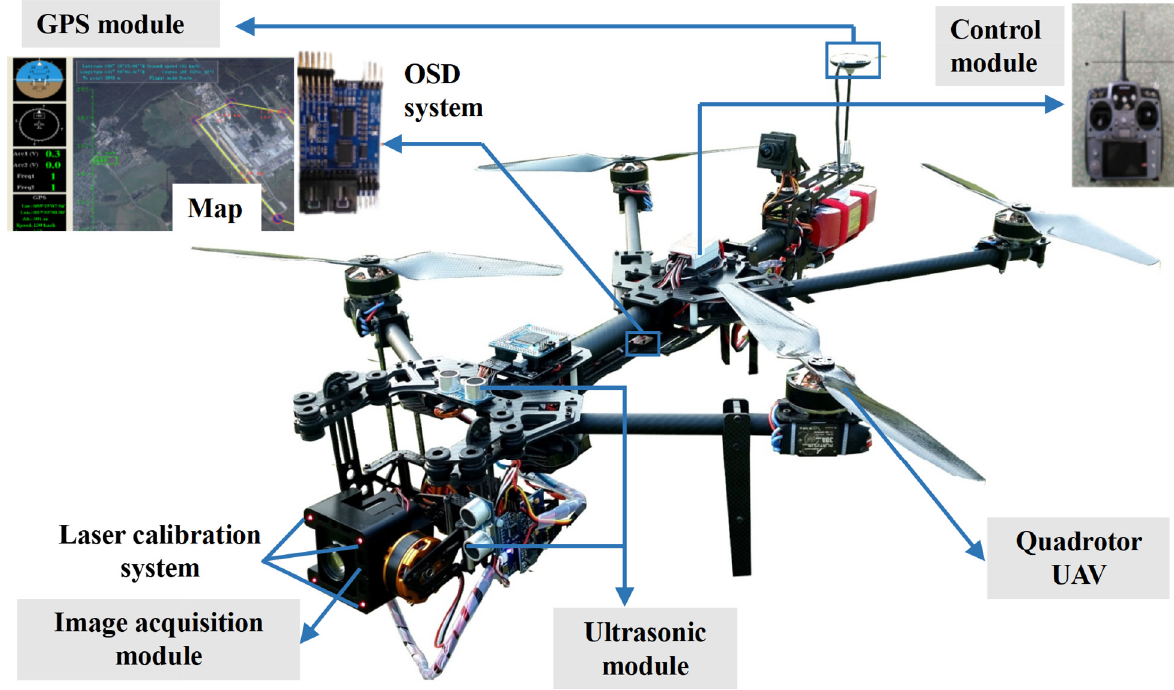
Figure 2. UAV-based system for crack acquisition.